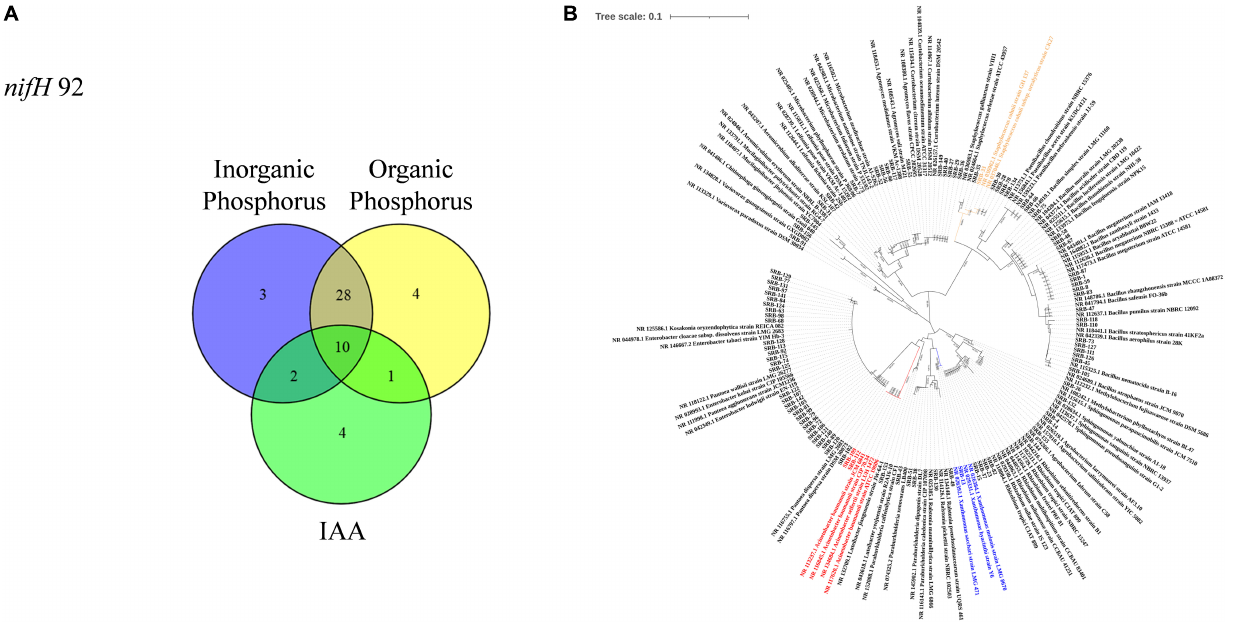
FIGURE 3 | Isolation and identification of microbes from roots of sugarcane. (A) Distribution of potentially beneficial functions among isolated root-associated microbes represented in a Venn diagram. (B) Phylogenetic tree was constructed using known sequences exhibited similar sequence similarity in GenBank database with NCBI BLAST program. Multiple sequence alignment was done using ClustalX 1.8 software package (http://wwwigbmc.ustrasbg.fr/BioInfo/clustalx), tree was constructed by neighbor-joining method using MEGA 7.0 (Kumar et al., 2016).